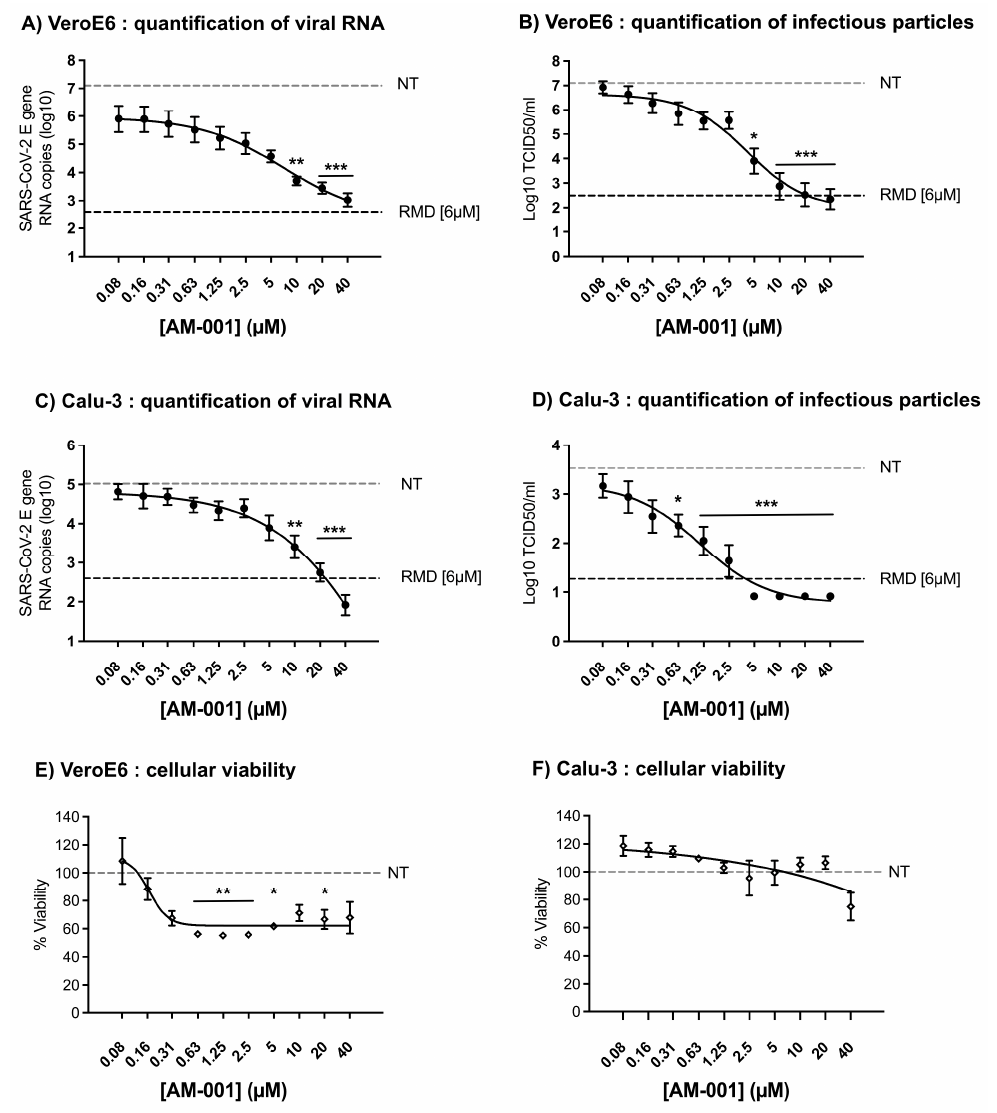
Figure 1. Inhibition of SARS-CoV-2 replication in VeroE6 and Calu-3 cells treated with AM-001 . Cells pretreated for two hours with the indicated concentrations of AM-001 or with Remdesivir (RMD) at 6 µM or with an equivalent concentration of DMSO (non-treated control NT) were infected at a multiplicity of infection of 0.001 with SARS-CoV-2. After one hour of virus inoculation, the cell culture medium was removed and replaced with cell culture medium containing AM-001 at the indicated concentrations or Remdesivir at 6 µM. Quantification of viral RNA levels ( A ) and infectious particles ( B ) from VeroE6 cells 24 h post-infection. Quantification of viral RNA levels ( C ) and infectious particles ( D ) from Calu-3 cells 24 h post-infection. Quantification of cellular viability from VeroE6 ( E ) and Calu-3 ( F ) cells treated with the indicated concentrations of AM-001. Results are expressed as means ± SEM from at least three independent experiments. Statistical analysis: one-way ANOVA with Dunnett’s multiple comparisons test (* indicates p < 0.05; ** indicates p < 0.01 and *** indicates p < 0.001 compared to NT cells). The dotted gray line corresponds to the mean result from NT cells. The dotted black line corresponds to the mean result from RMD-treated cells.